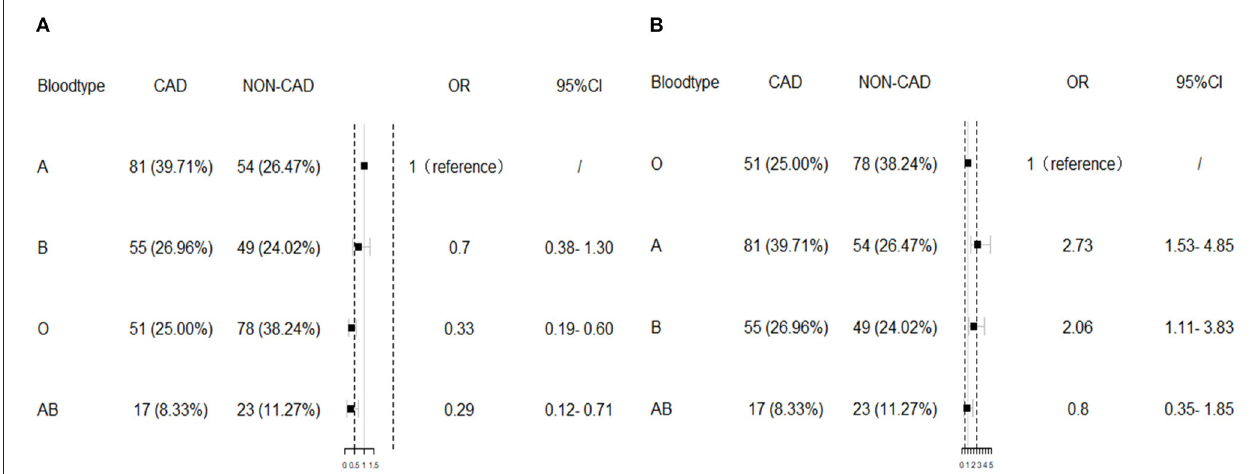
FIGURE 1 | The multivariate logistic regression results. Blood group O significantly associated with low risk of coronary artery disease (CAD) compared with blood group A (A) , while A and B blood groups were related to high risk of CAD compared with O blood group (B) after adjustment of body mass index (BMI), hypertension, hypercholesterolemia, diabetes mellitus (DM), smoking, glucose, white blood cell (WBC), hemoglobin, platelet, serum phosphorus, serum calcium, dialysis type, and dialysis duration. OR , odds ratio.